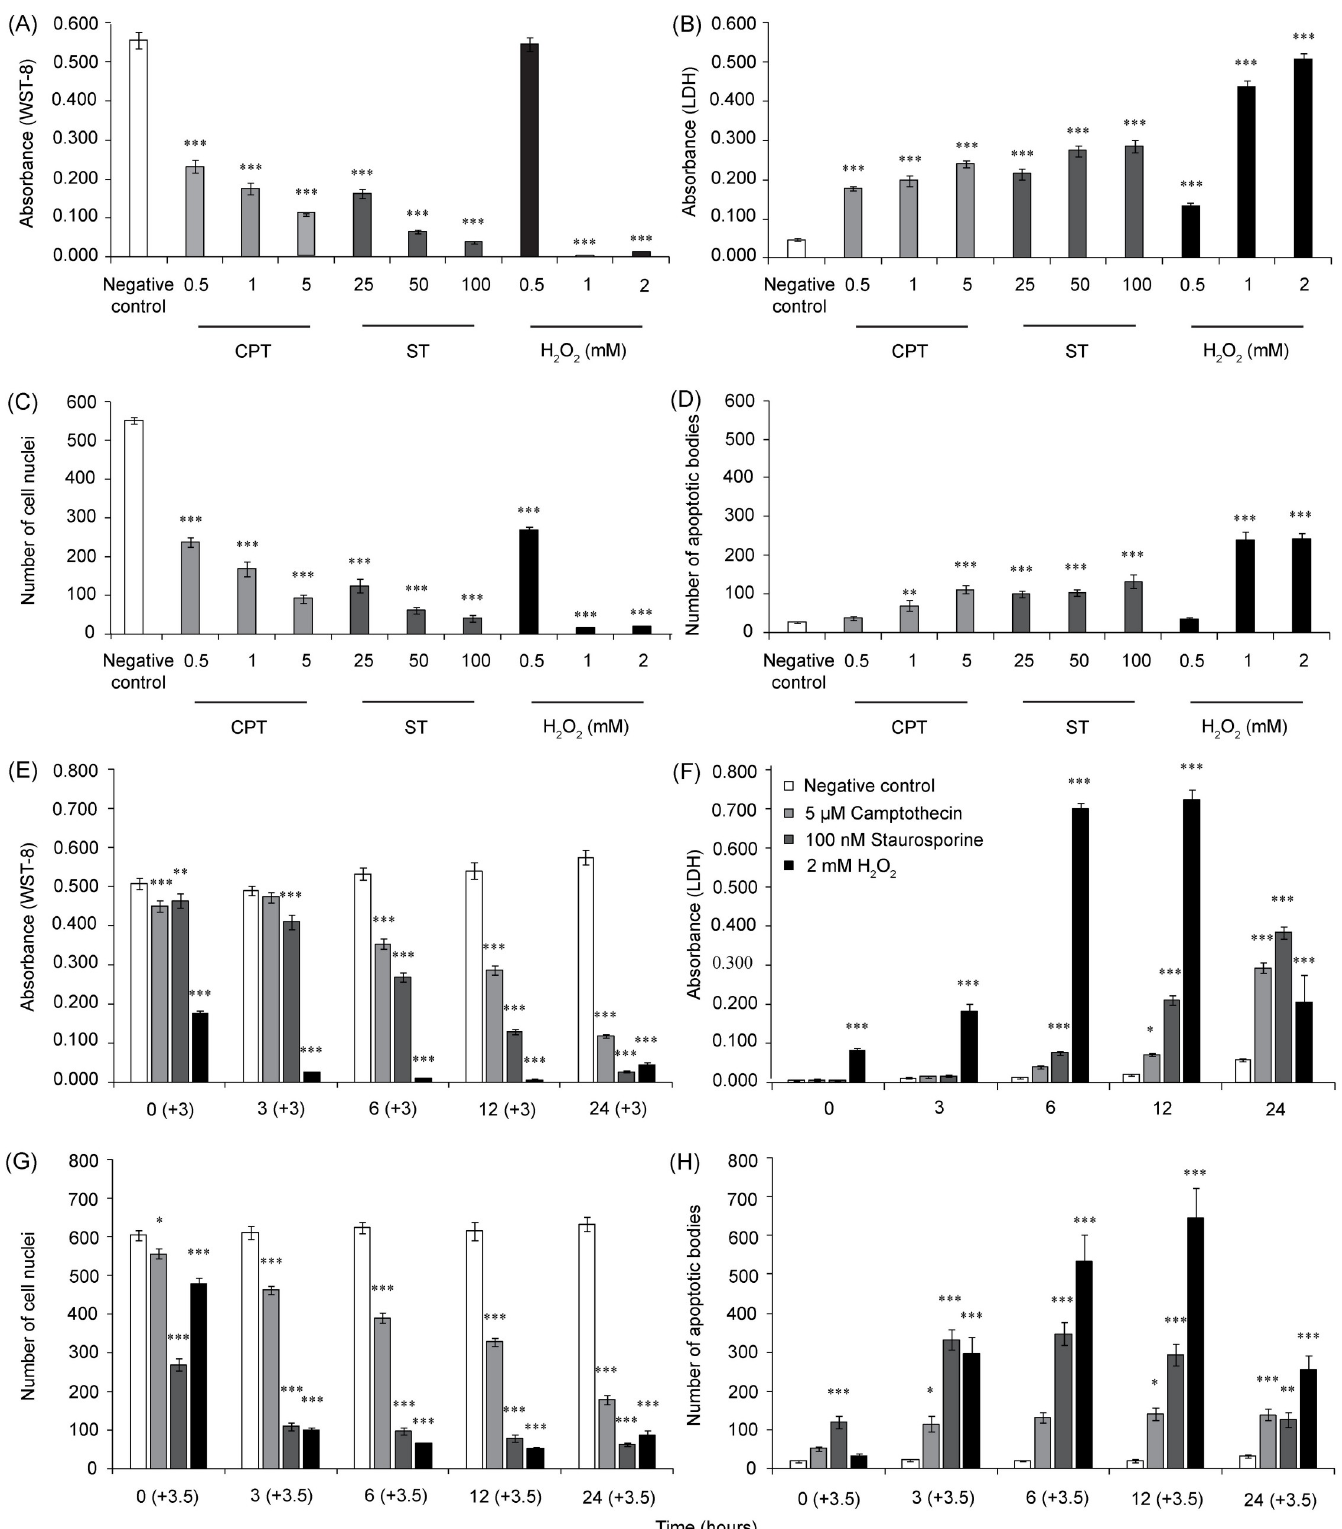
Fig 3. Evaluation of CDS assay performance. The HUVECs in the 96-well plate were treated with different concentrations of camptothecin, staurosporine or H 2 O 2 for 24 hours (A–D), or with 5 μ M camptothecin, 100 nM staurosporine or 2 mM H 2 O 2 for 0, 3, 6, 12 and 24 hours (E–H). Cell viability was measured by WST-8 assay (A,